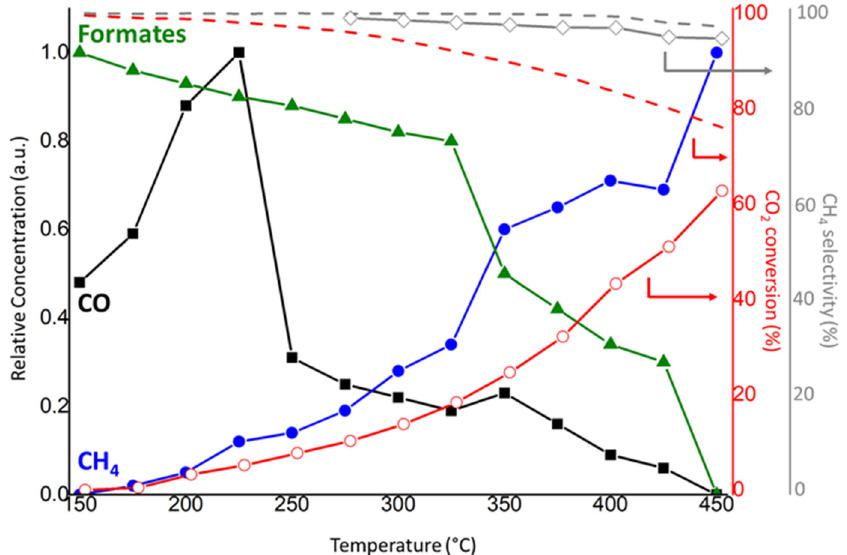
Figure 5. Evolution of the relative concentrations (left axis) of CH 4 (g), adsorbed CO (2050–1750 cm − 1 ) and formates (1403 cm − 1 ); CO 2 conversion (%, right axis, red) during CO 2 methanation over 3Ru/CsUSY (connected symbols) and according to the thermodynamic limit of the reaction (dashed lines); CH 4 selectivity (%, right axis, grey) during CO 2 methanation over 3Ru/CsUSY (connected symbols) and according to the thermodynamic limit of the reaction (dashed lines).